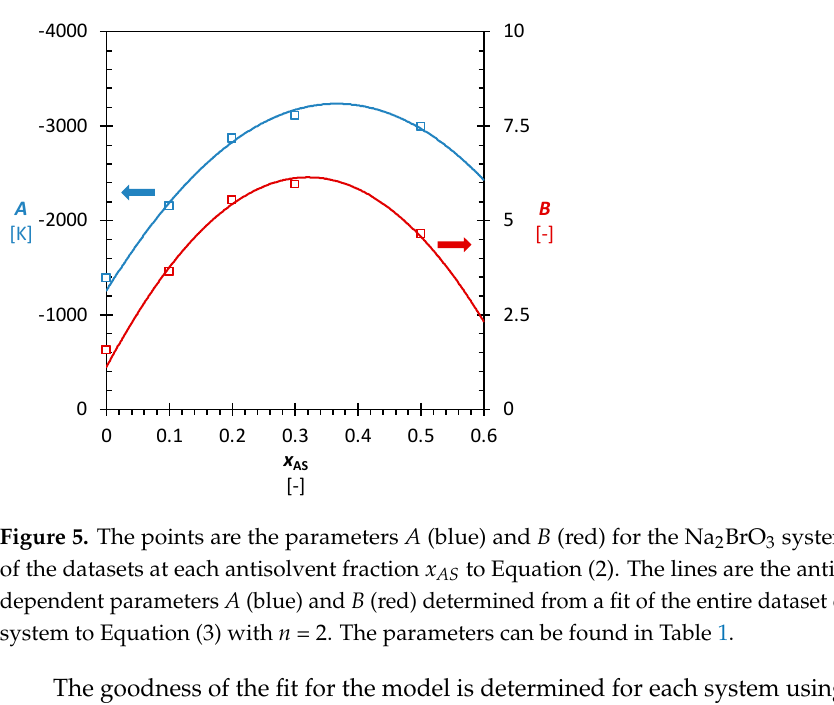
Table 1. Fitting parameters and their standard errors obtained from the model Equation (3) using the entire dataset for a combination of compound, solvent and antisolvent. The relative standard deviations σ ln x and σ x from Equation (4) for each system are also provided.